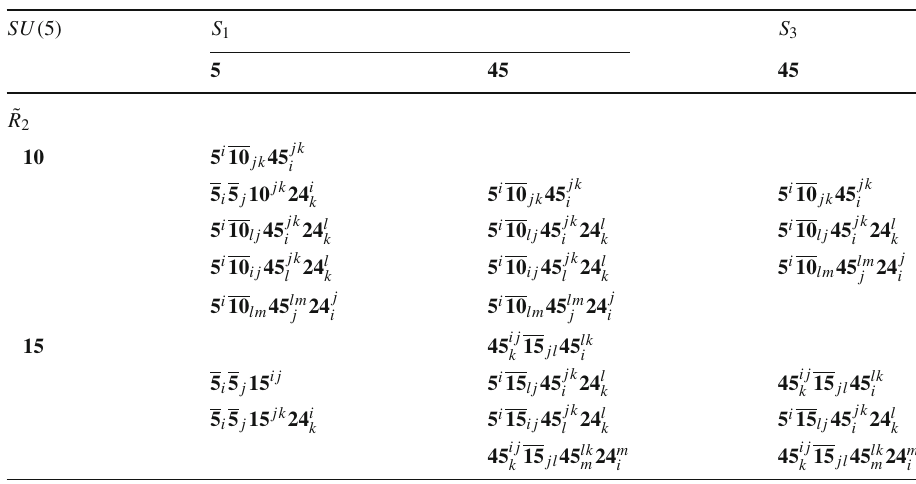
Table 2 SU ( 5 ) operators that generate mixing between the 1 / 3 electric charge scalar LQs if one assumes that the only VEVs in the theory are the ones proportional to v 24 , v 45 , and v